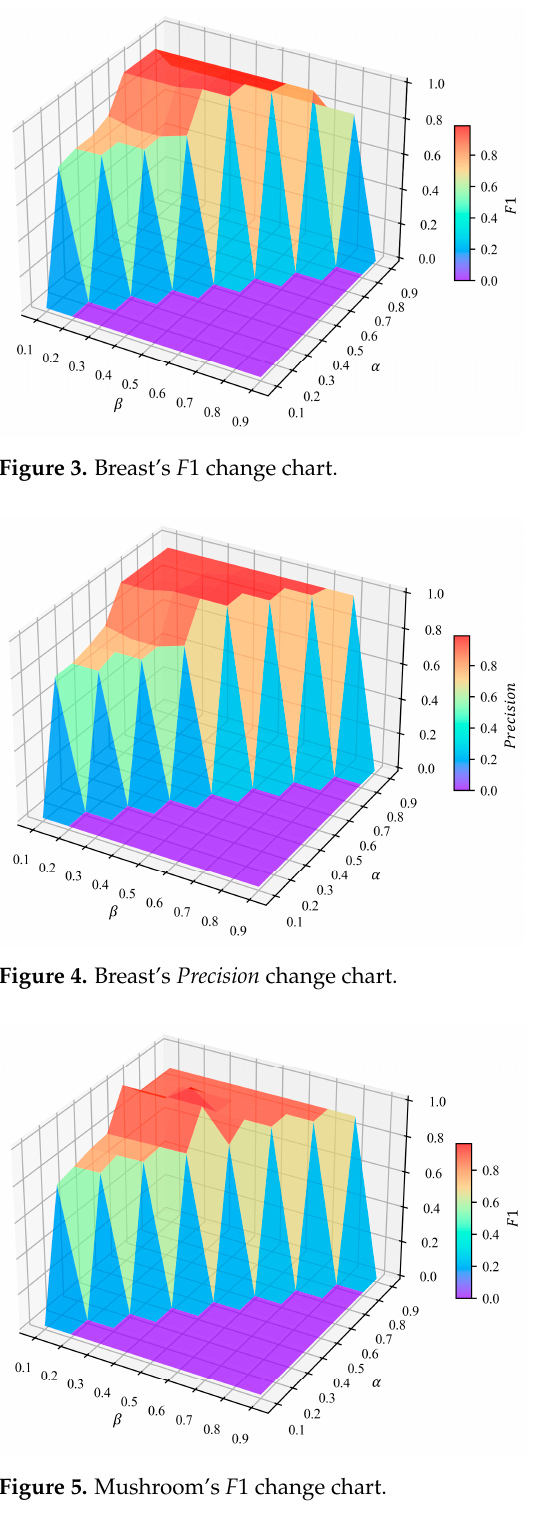
Figure 6. Mushroom’s Precision change chart.